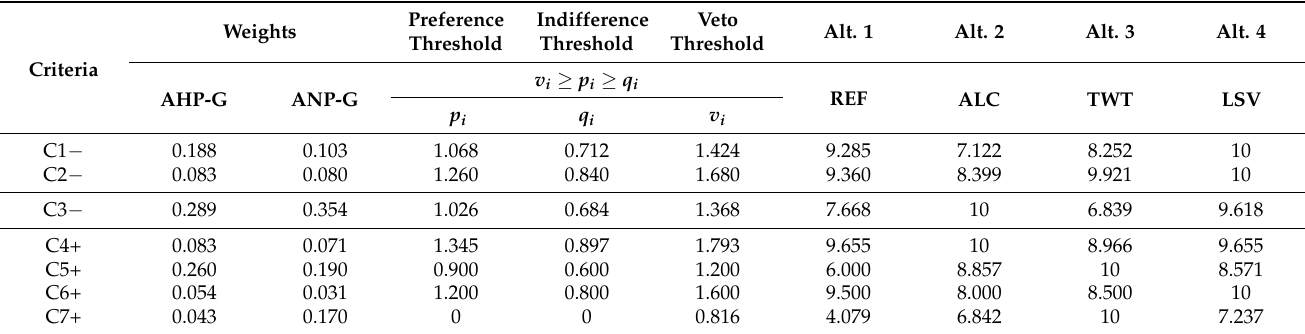
Table 11. Normalized decision matrix on impact assessment results and pseudo-criteria common to AHP and ANP-ELECTRE IS.